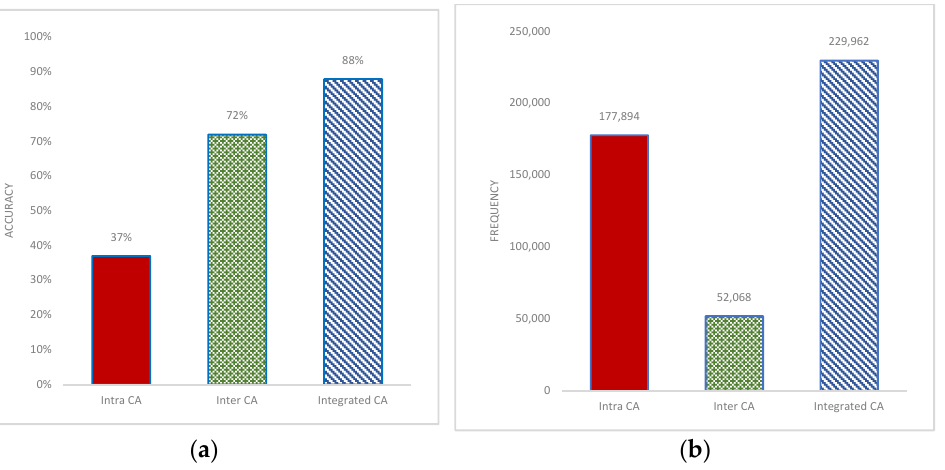
Figure 4. Classification accuracy rate and frequency of aberrations in intrachromosomal, interchro- mosomal, and integrated aberrations. The frequency is computed based on the data obtained from the COSMIC. Intrachromosomal aberrations are more frequent but have less effect in prediction in contrast to interchromosomal aberrations that are less frequent but significantly affect prediction accuracy. ( a ) classification accuracy for inter CA, intra CA, and integrated CA based on GraphChrom ( b ) Frequency of inter CA, intra CA, and integrated CA.